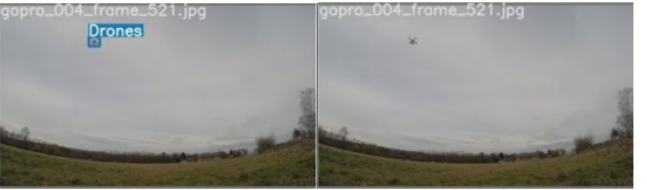
Figure 16. Left image is the ground truth. In the right image, YOLOv5 is not able to